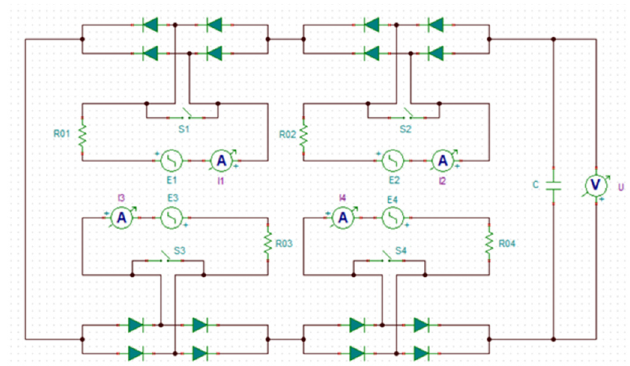
Figure 9. State-switched array energy harvesting circuit.